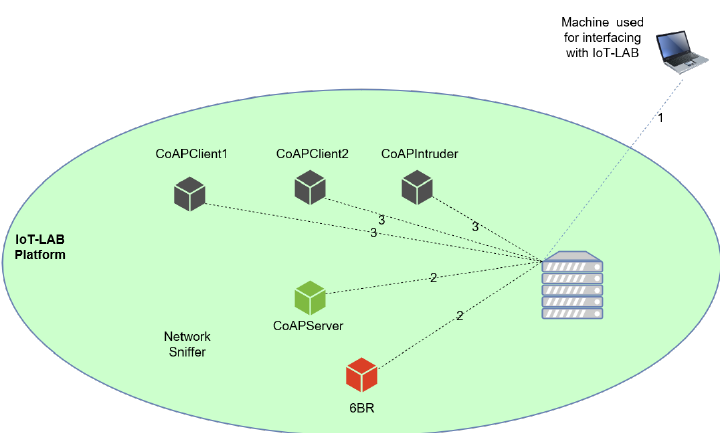
Figure 3. User interface developed to support the training phase.